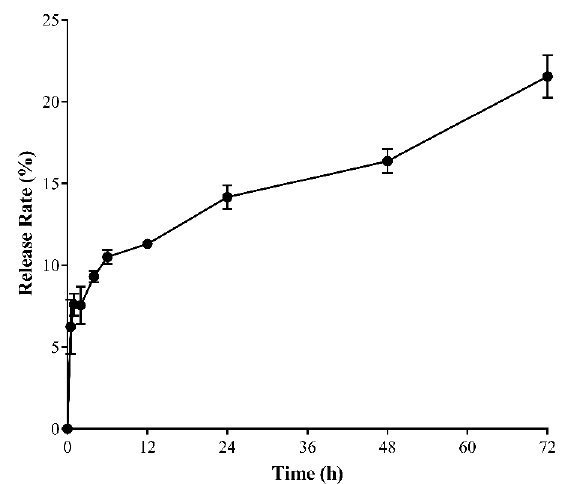
Figure 1. The release rate of CD from the SMA micelle. The release rate was determined using an in vitro dialysis system . Each point represents the mean ± standard deviation (SD) of triplicates. Data are presented as the average ± the standard error of the mean (SEM) ( n = 3).